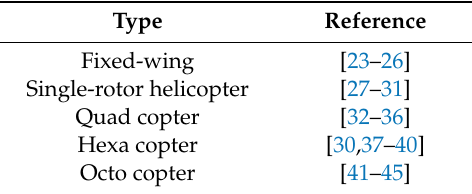
Table 2. Di ff erent types of RPAS (remotely piloted aircraft system) models developed in past studies for precision agriculture.